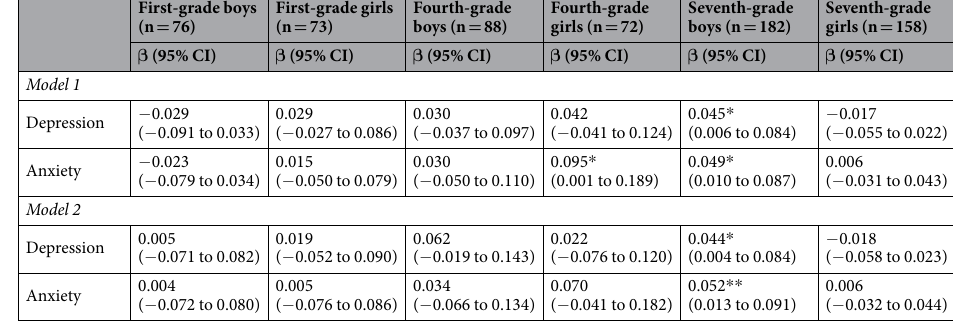
Table 3. Effects of d epression and anxiety scores on homocysteine by sex and grade in Taiwan: results from linear regression models. Model 1: Crude model. Results were calculated per 10-unit (1 SD) increment of depression and anxiety (continuous) scores. Model 2: For both models of depression and anxiety, results were obtained after adjustment for HDL, AST, BMI, ECG, systolic blood pressure, fasting blood glucose, fruit consumption frequency, and vegetable consumption frequency. Results were calculated corresponding to 10- unit (1 SD) increments in depression and anxiety scores. * P < 0.05; ** P < 0.01; *** P < 0.001. CI: confidence